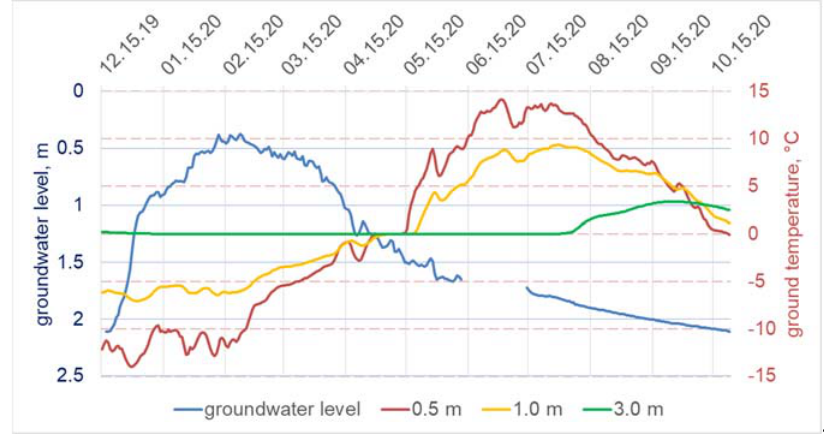
Figure 5. Groundwater level, m, and ground temperature at three depths, ◦ C, for the period December 2019–October 2020 in the borehole 3/16-S.